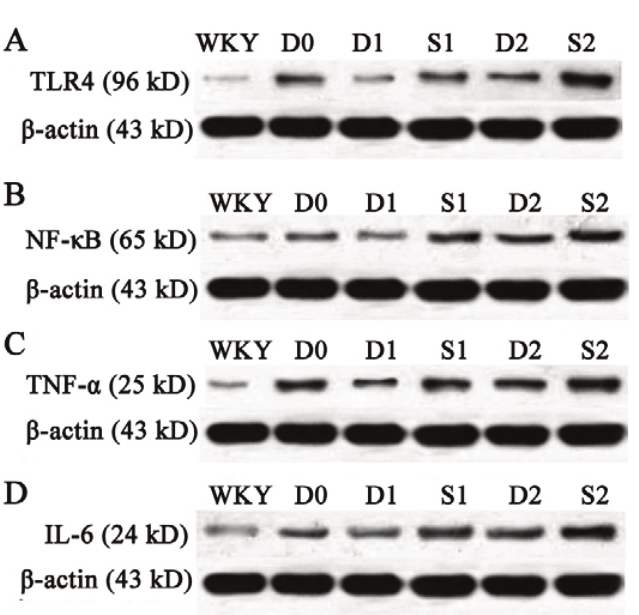
FIGURE 4 - Protein expressions in the myocardium of rats in different groups. A, TLR4; B, NF-κB; C, TNF-α; D,